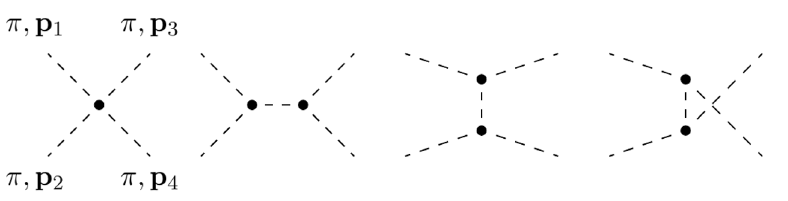
Figure 5 . Feynman diagrams and notation for the phonon-phonon scattering process. The black dots indicate 4-point or 3-point interaction terms in the Lagrangian in eq. (3.10).